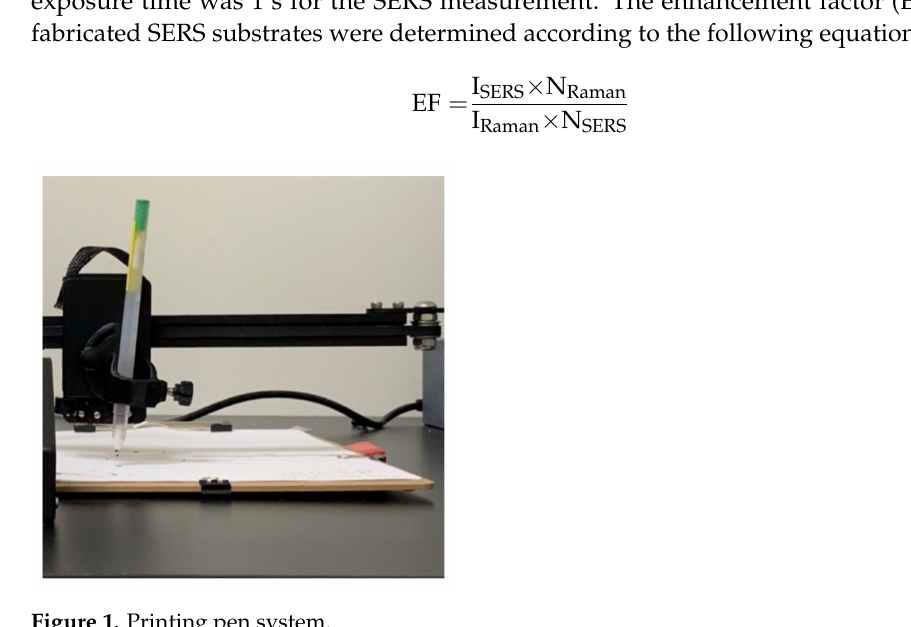
Figure 1. Printing pen